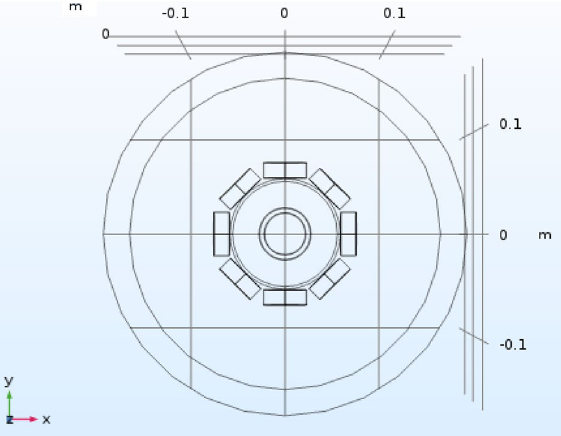
Figure 2. Mean values of the real part ( A ), imaginary part ( B ), amplitudes ( C ) and phase angles ( D , in radian) of induced complex voltages at different single excitation frequencies, where the phantom tubes have a conductivity of 1.3 × 10 6 S / m and different relative permeability, of 1, 10 100 and 4000